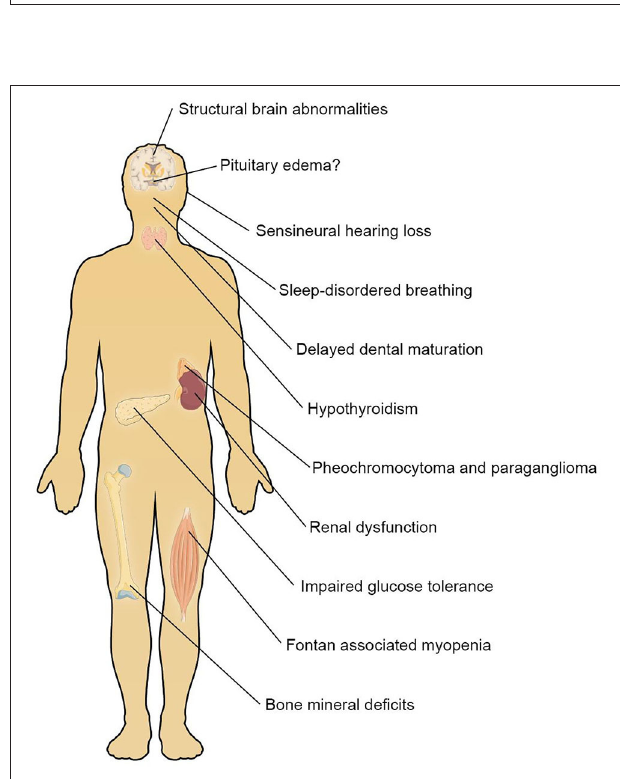
FIGURE 2 | Main findings per organ